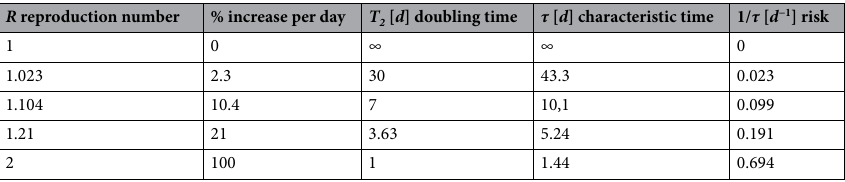
(cid:31) N dN (cid:31) t for dt ∼= ≡